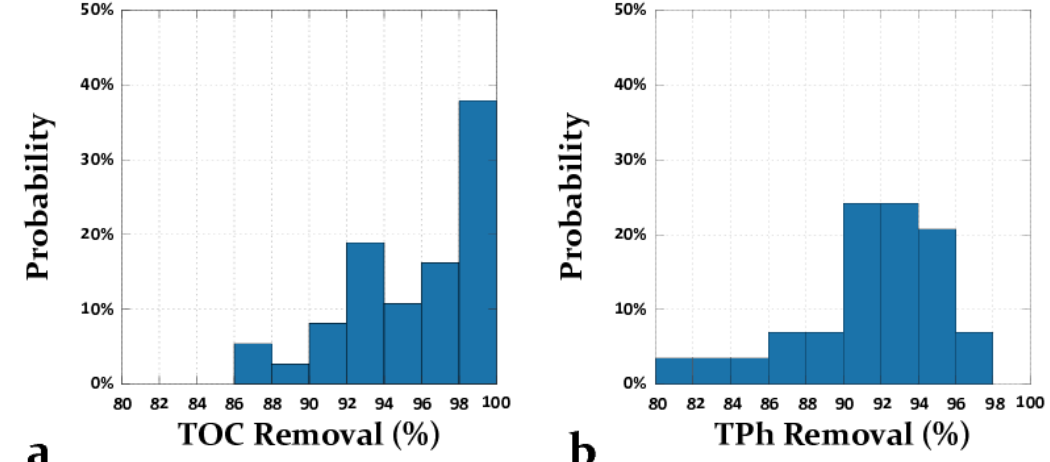
Figure 4. Probability plots of feed and permeate characteristics. Plots of ( a ) the TOC; and ( b ) the TPh ffi ciency during MBR acclimatization removal efficiency during MBR acclimatization period. removal e